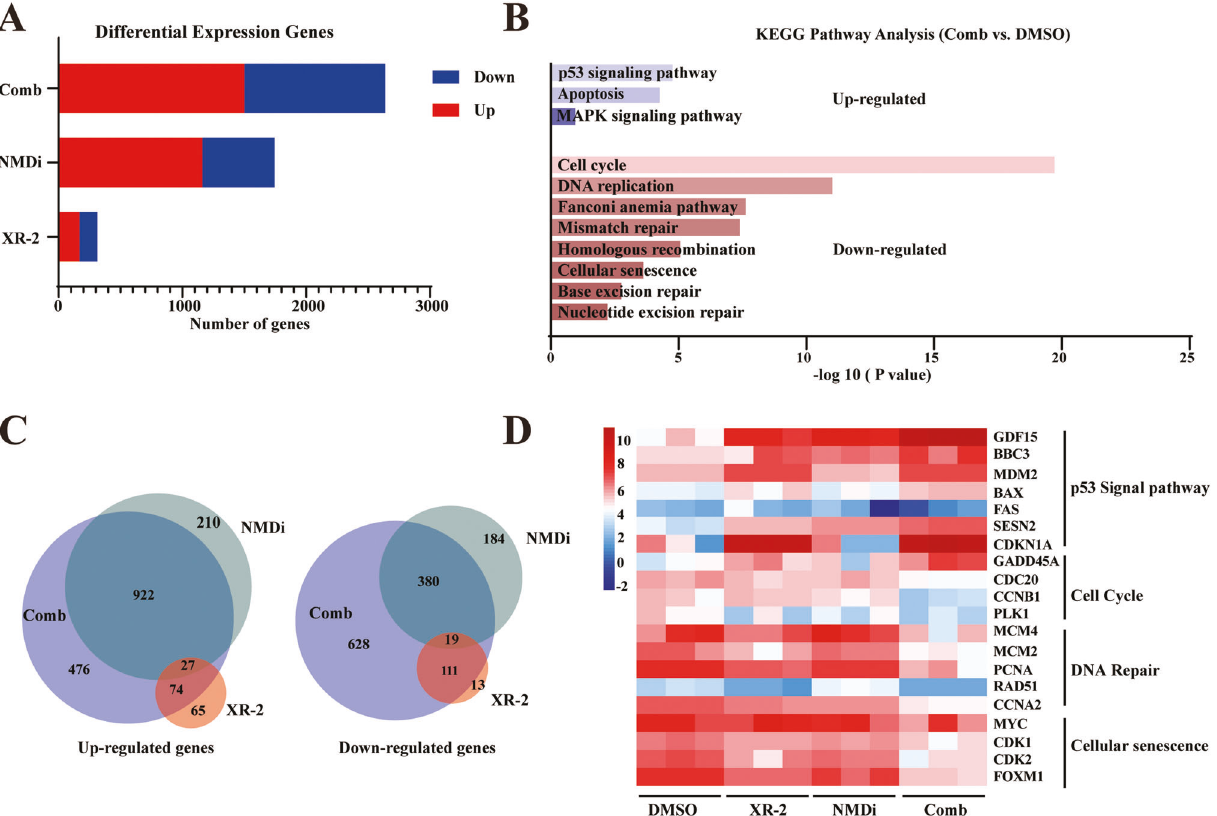
Fig. 6 RNA-sequencing analysis of 22Rv1 cells treated with NMDi or XR-2 alone or in combination. 22Rv1 cells were treated with 3.2 µM XR-2 and 3.2 µM NMDi alone or in combination for 24 h in triplicate. A Numbers of DEGs in the single or combination treatment groups. All DEGs were compared between the drug-treated groups and DMSO-treated groups. B KEGG analysis results of the most signi fi cantly enriched pathways in the combination treatment group. C Venn diagram of upregulated and downregulated genes in the single or combination treatment groups. D The heatmap exhibited the representative genes of the p53 signal pathway, DNA repair pathway, cell-cycle pathway and cellular senescence pathway in single or combination treatment groups. Comb: combination treatment group. N =